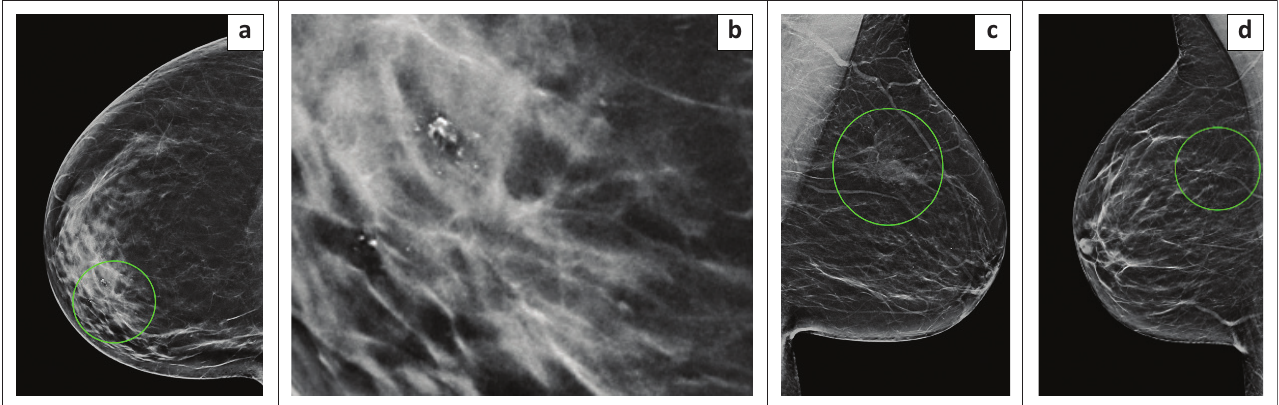
FIGURE 4: Examples of lesions that were suspicious for malignancy on breast imaging, but yielded benign histology. (a) Craniocaudal view and (b) magnified image showing architectural distortion and suspicious microcalcifications in the inner right breast. Histology revealed fat necrosis, (c) Mediolateral oblique view indicating a poorly circumscribed mass with spiculated margins in the upper left breast, associated with architectural distortion and amorphous microcalcifications. Histology revealed an intra-ductal papilloma, (d) Mediolateral oblique view demonstrating architectural distortion in the upper right breast which yielded benign breast tissue on TABLE 5: Comparison table of studies evaluating radiological-pathological discordance or histological underestimation in stereotactic breast biopsies. Study